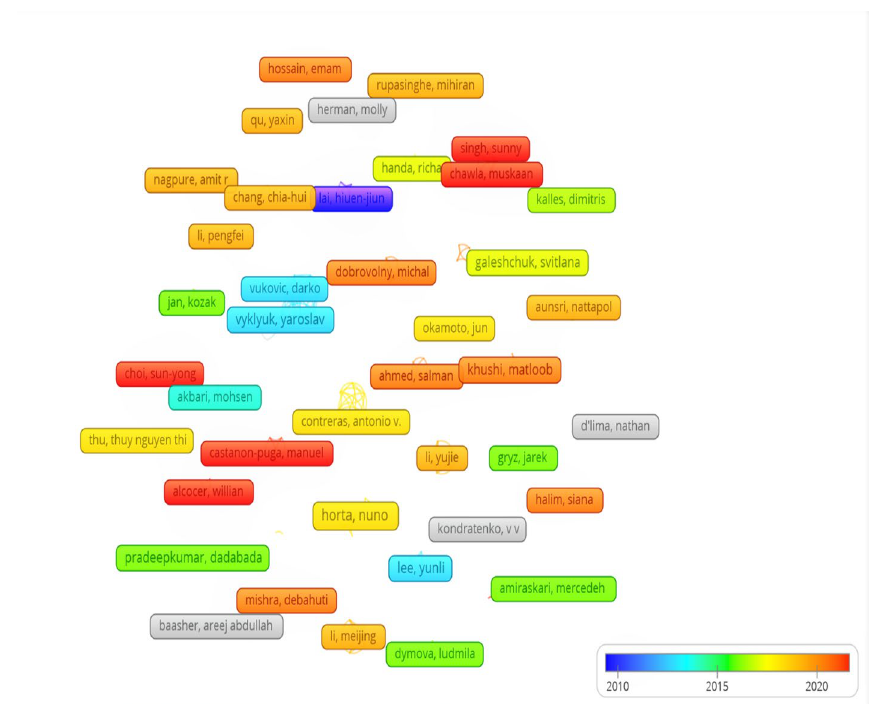
Fig. 3 VOSviewer (http:// www. vosvi ewer. com/) was used to undertake a bibliographic coupling analysis. The number of references that are common across the publications evaluated is represented by the size and color of the nodes. The number of referenced references that two publications have in common is indicated by the link’s strength